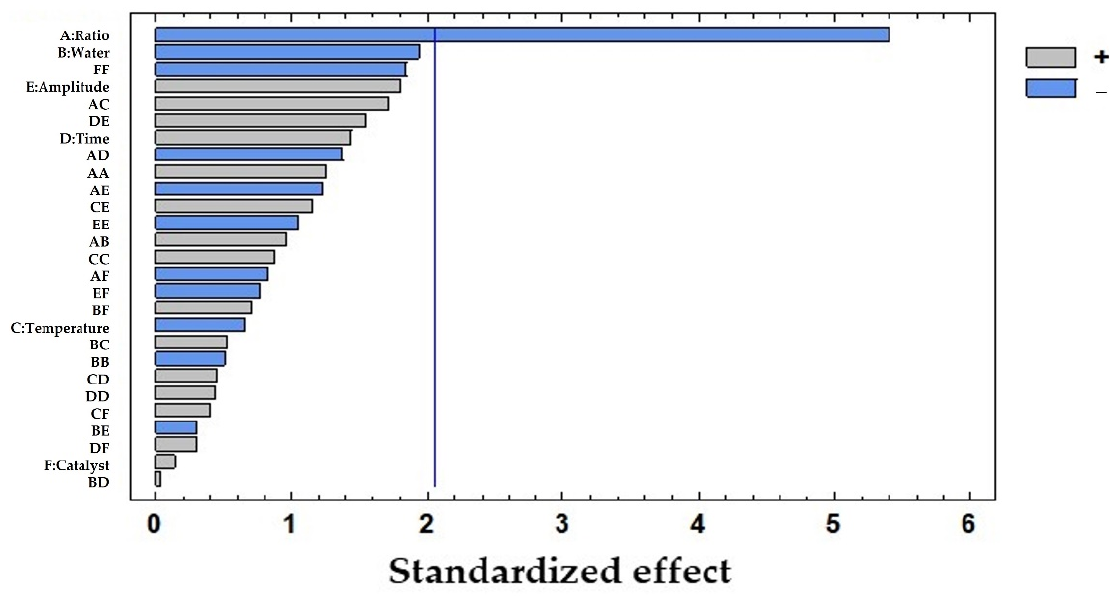
Figure 2. Pareto chart results from the total polyphenols extracted (mg/g dw) from pine needles using USE: A: solid-to-solvent ratio (g sample in 10 mL solvent); B: water (%) in solvent; C: temperature of extraction ( ◦ C); D: time of extraction (h); E: amplitude (%); F: catalyst concentration of H 2 SO 4 (M). The vertical line marks 95% of confidence.